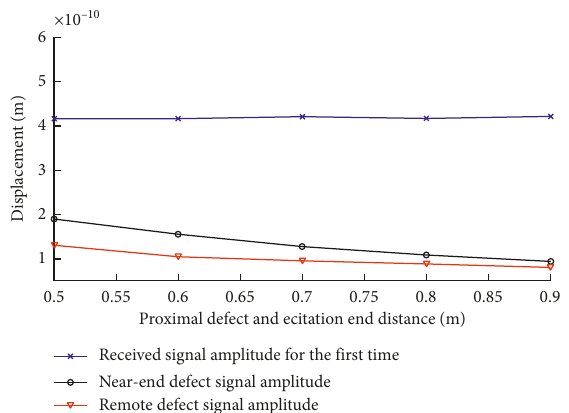
Figure 10: Signal amplitude curves with different relative distances.